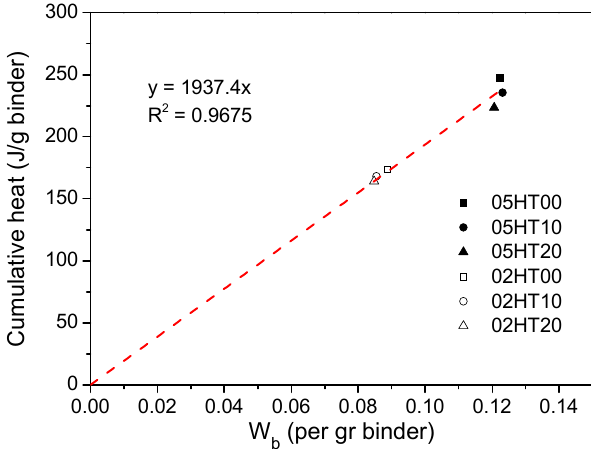
Figure 16. Relationship between cumulative heat and chemically bound water.